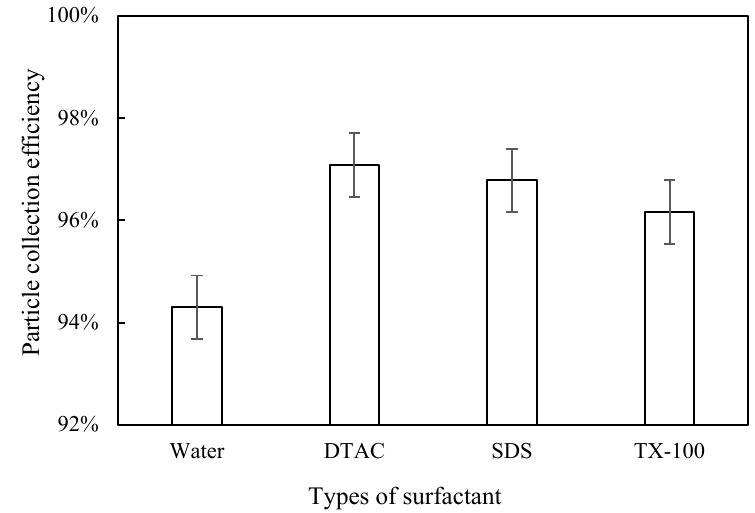
Figure 10. Effect of surfactant type on dust removal efficiency.